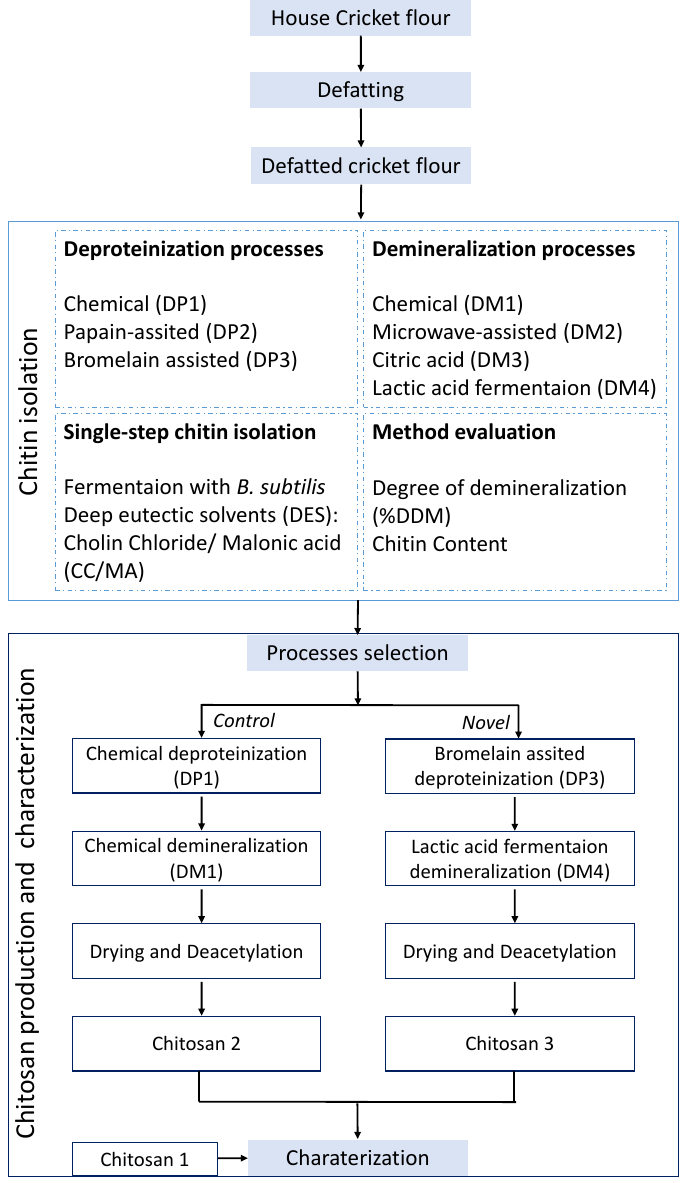
Figure 1. Flow chart of the experimental setup of the present study.